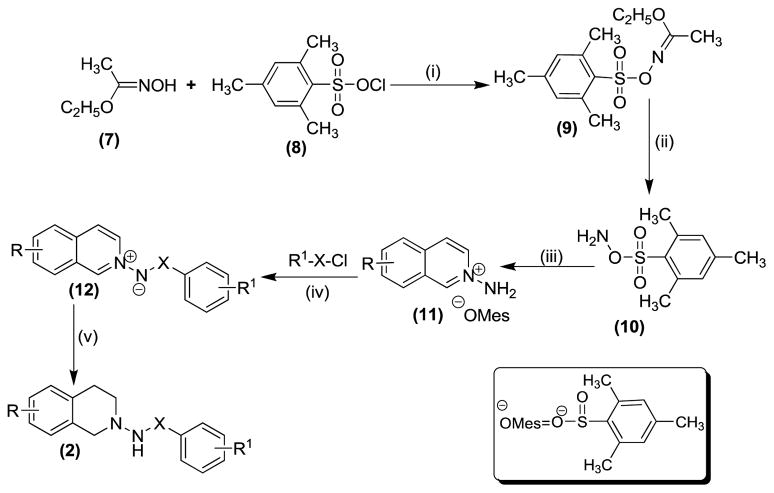
Reaction Conditions: (i) DMF, 0 °C, 45 min, (ii) 70 % HClO4, p-dioxane, 0 °C, 45 min, (iii) Substituted isoquinoline, dry CH2Cl2, 0 °C, 5h, (iv) 4-substituted acyl/sulfonyl chlorides, dry THF, 70 °C, 12h, (v) NaBH4, abs. EtOH, 7 h; R = OH, Br, NH2; X = CO, SO2; R1 = 4-C2H5, 3-OCH3, 2-OCH3, 2-C2H5